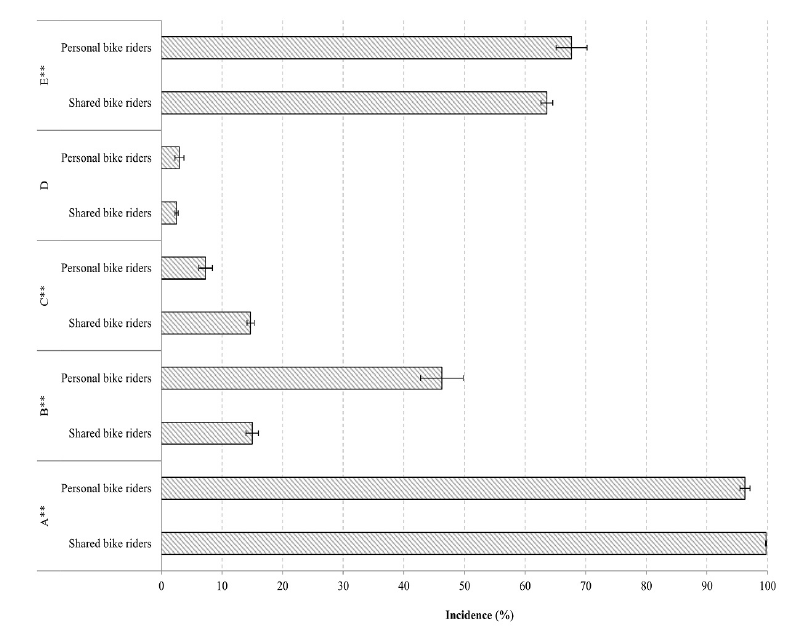
Figure 1. Incidence of unsafe cycling behaviors among shared vs. personal bike riders in Changsha, China. Note: A: not wearing a helmet, B: cycling through a red light, C: riding in opposite direction of tra ffi c, D: not holding the handlebar with both hands, E: riding on motorway or sidewalk. *: p < 0.05; **: p <